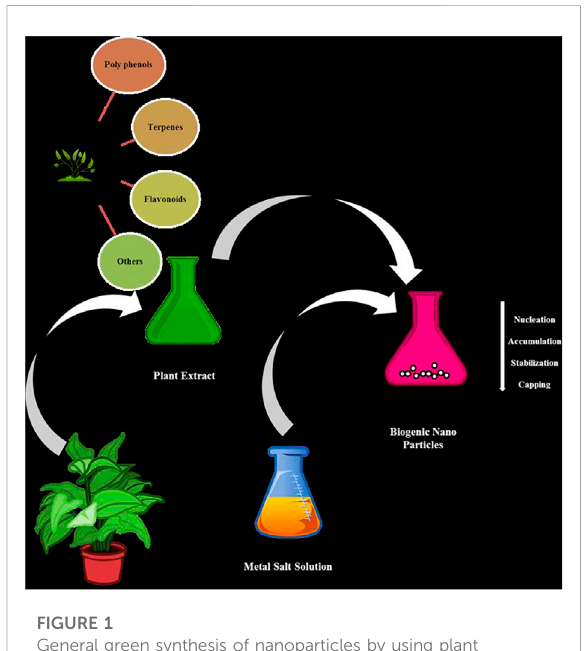
FIGURE 1 General green synthesis of nanoparticles by using plant extracts and metal salt solutions.